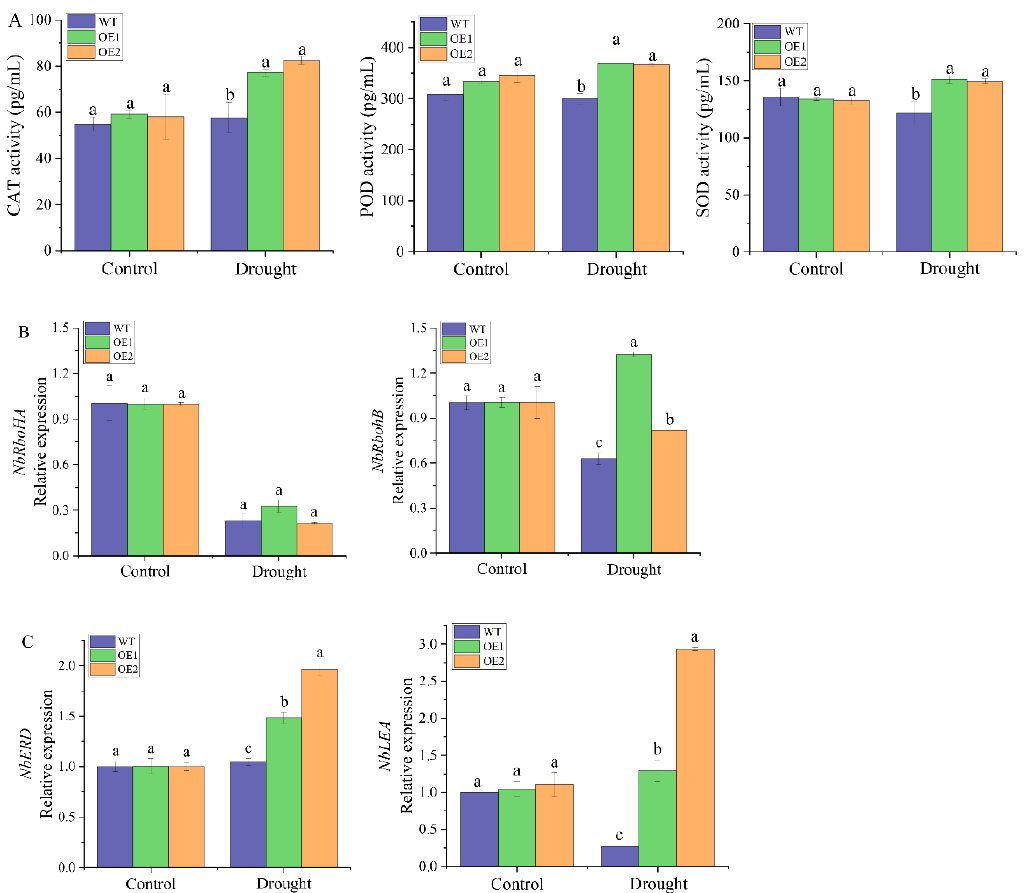
Figure 9. Determination of physiological index and expression level of stress-related genes in transgenic Nicotiana benthamiana plants overexpressed the ScDREB2B-1 gene under drought stress for 2 d. ( A ) Activities of catalase (CAT), peroxidase (POD) and superoxide dismutase (SOD). ( B ) Relative expression level of reactive oxygen species (ROS) synthase-related genes NbRbohA and NbRbohB . ( C ) Relative expression level of osmotic stress-related genes NbERD and NbLEA . WT: wild-type N. benthamiana . OE1 and OE2: different transgenic N. benthamiana lines overexpressed ScDREB2B-1. All data points were means ± standard error ( n = 3). Significant differences were found between different letter substitutes on the column calculated by Duncan’s new multiple range test ( p -value < 0.05). 2.8. Proposed Model for the Overexpression of Sugarcane ScDREB2B-1-Mediated Regulation of N. benthamiana Plants under Drought Stress Based on these results, the sugarcane ScDREB2B-1 gene could enhance the drought resistance of N. benthamiana plants by regulating the expression of stress response genes, together with physiological and biochemical reactions. Collectively, compared with WT plants, the overexpression of the ScDREB2B-1 gene improved the drought tolerance of transgenic N. benthamiana by activating the ABA signaling pathway to enhance the expression of the ABA response gene ( NbNCED ) and the ABA content, upregulating the expression level of the stress-related genes ( NbRbohB , NbERD and NbLEA ) and then changing the physiological and biochemical levels of the plants, such as modulating the intracellular ROS level through the enhanced activities of CAT, POD and SOD and increasing the relative water and proline content (Figure 10).